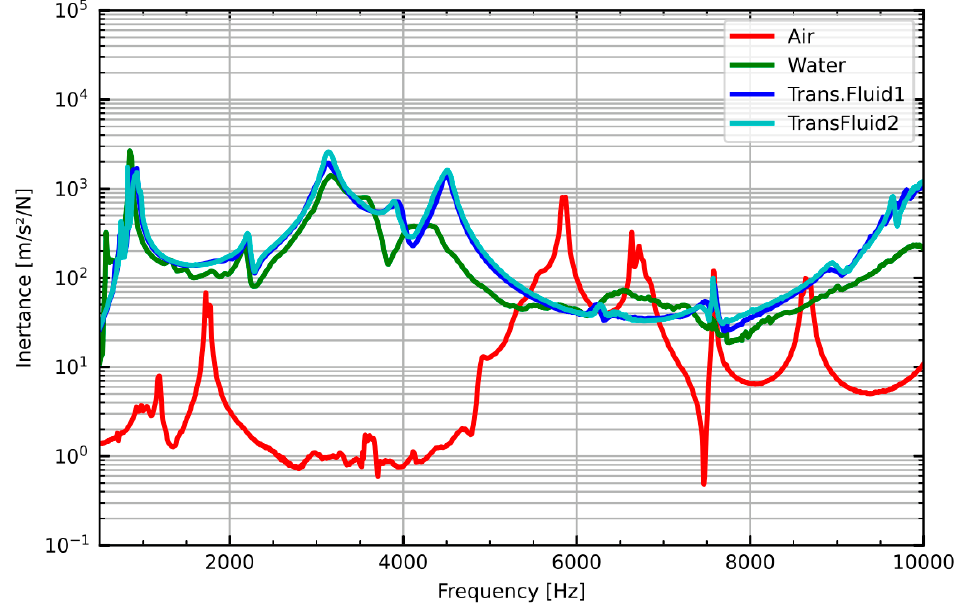
Figure 6. Relative comparison of FRFs for different media inside the fixture; for air, water, transmission Fluid 1 and transmission fluid 2.